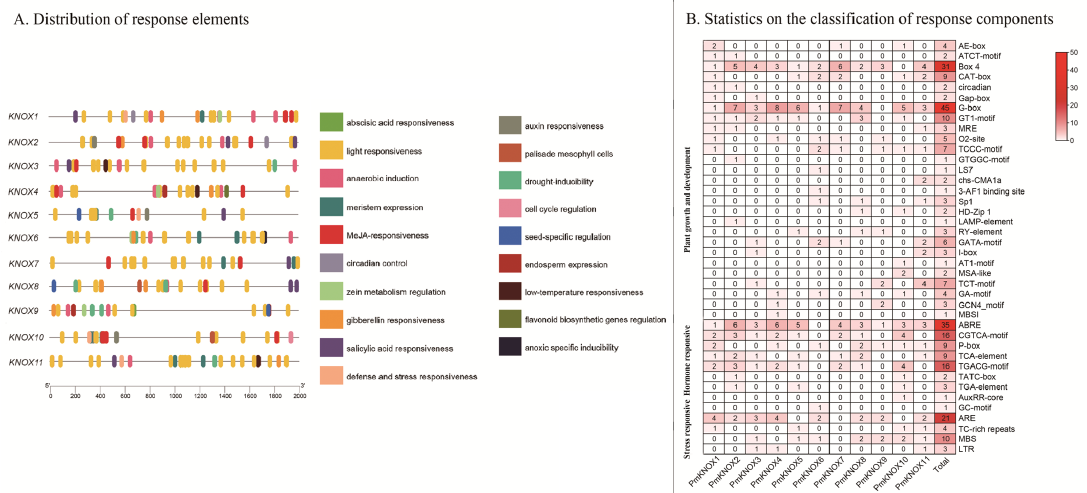
Figure 4. Predicted cis-elements in the PmKNOX promoters. ( A ) Analysis of the distribution of response elements on PmKNOX promoters. ( B ) Statistics on the classification and number of PmKNOX promoter response elements. The 2.0 kb sequence upstream from the coding sequence of PmKNOX genes was analyzed using the PlantCARE database.